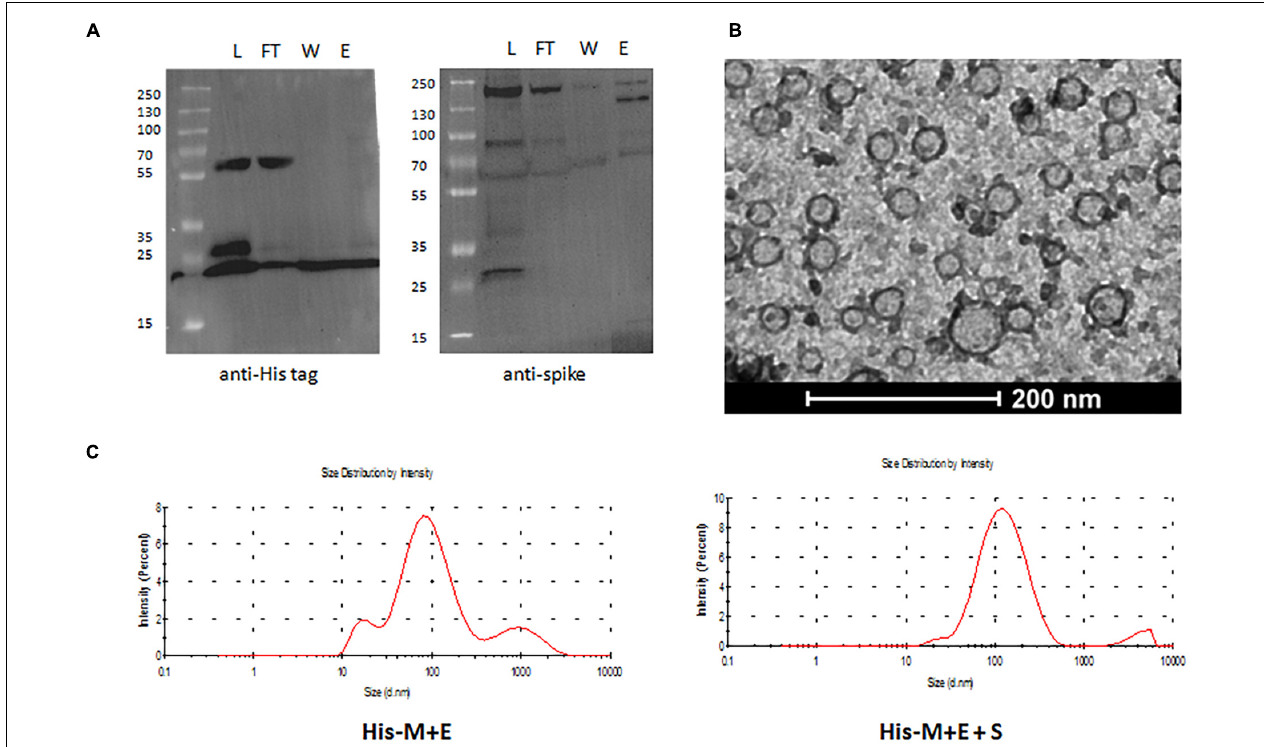
FIGURE 4 | Purification and characterization of His-tagged SARS-CoV-2 VLPs. (A) Western blotting analysis of fractions eluted from Ni-NTA purification: L, load; FT, flow through; W, wash; E, elution. Proteins on the left membrane were detected with anti-His antibody (reflecting presence of the His-M protein), whereas on the right are membrane with anti-S antibody. (B) TEM image of His-M + E VLPs. (C) DLS measurements of mean hydrodynamic diameter of His-M + E (left) and His-M + E + S (right) VLPs. SARS-CoV-2, severe acute respiratory syndrome coronavirus 2; VLP, virus-like particle; NTA, nitrilotriacetic acid; TEM, transmission electron microscopy; DLS, dynamic light